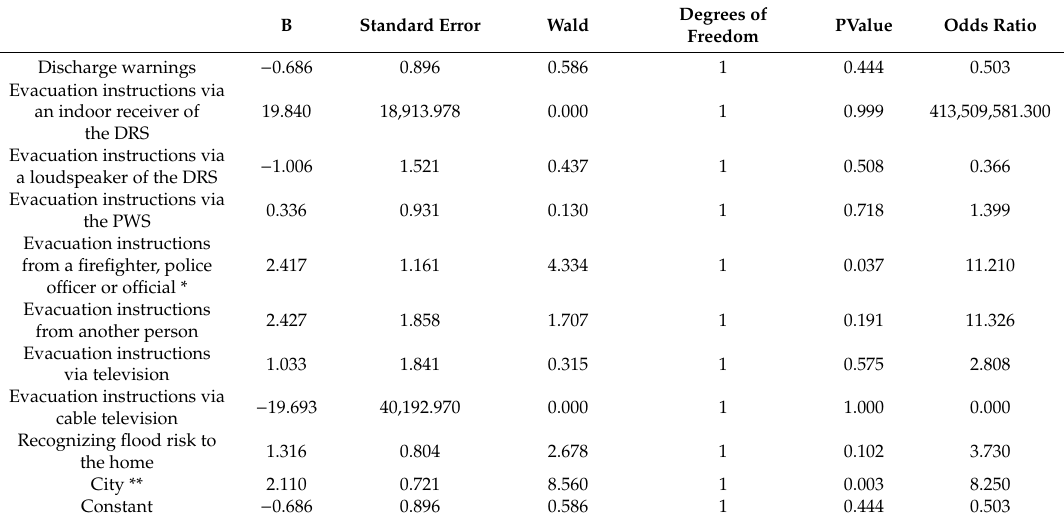
Table 6. Variables related to early evacuation (2) (logistic regression analysis).